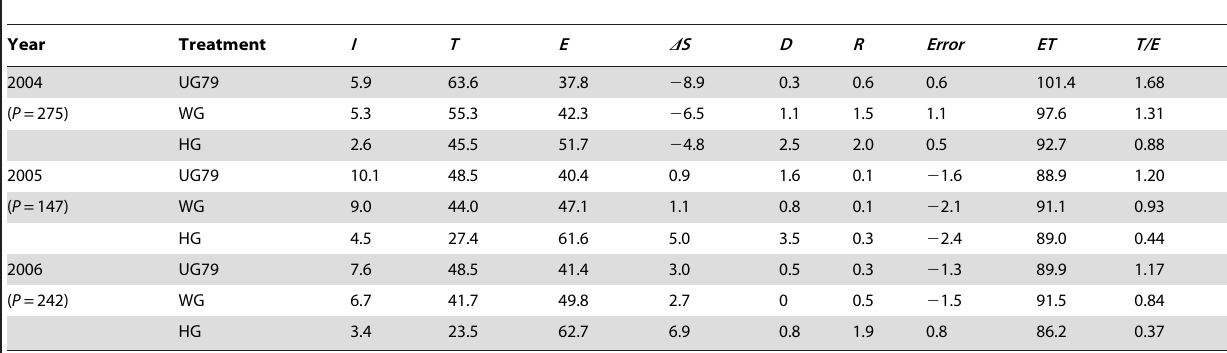
Table 2. Simulated water budget components during growing periods in 2004–2006, inverse simulation results with Hydrus-1D.